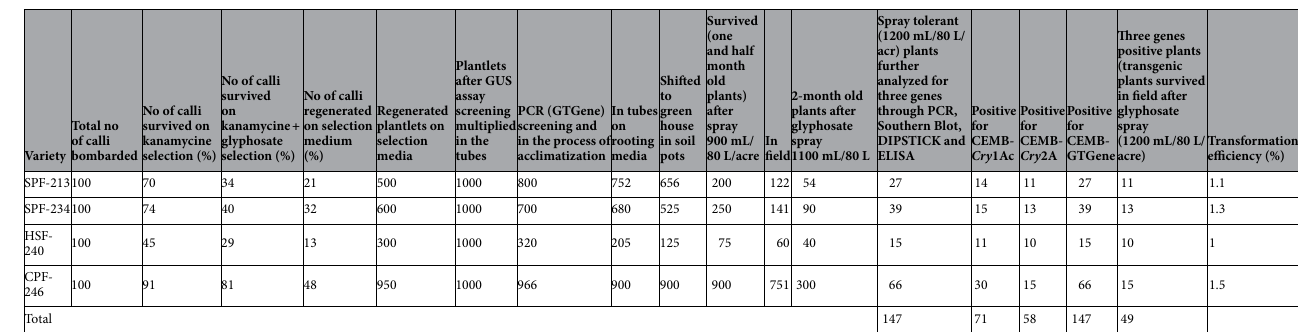
Table 2. Biolistic transformation in sugarcane and selection of transgenic